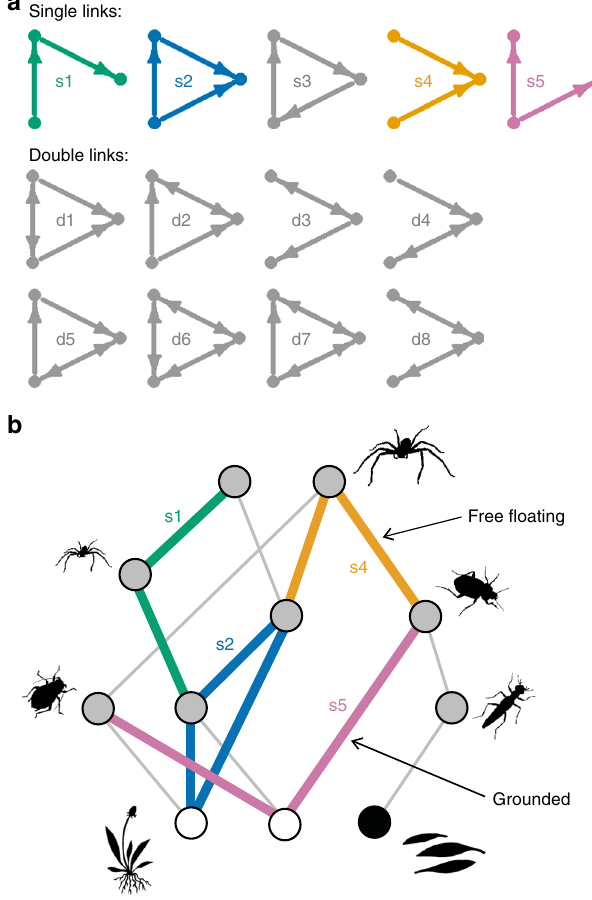
Fig. 1 Three-species motifs in food webs. a The 13 possible connected triads, which may contain only single feeding links (labelled with ‘ s ’ ) or at least one double feeding link ( ‘ d ’ ). The common motifs are shown in colour: tri-trophic chains (e.g. a plant fed on by a herbivore which is then preyed upon by a predator; s1), omnivory (the species at the top of the food chain feeds on both other species; s2), apparent competition (two resources that are fed on by the same consumer; s4) and exploitative competition (a resource shared by two consumers; s5). b A hypothetical example of the consumer community (grey nodes) observed on a plot with two plant species (white nodes) and a node for detritus (black node). Coloured links show examples of the common triads that reoccur within the larger network. In this case, the omnivory (s2; blue) and exploitative competition (s5; pink) motifs are grounded (i.e. connected to a basal resource), while the tri-trophic chain (s1; green) and apparent competition (s4; orange) motifs are free fl oating (i.e. not connected to a basal